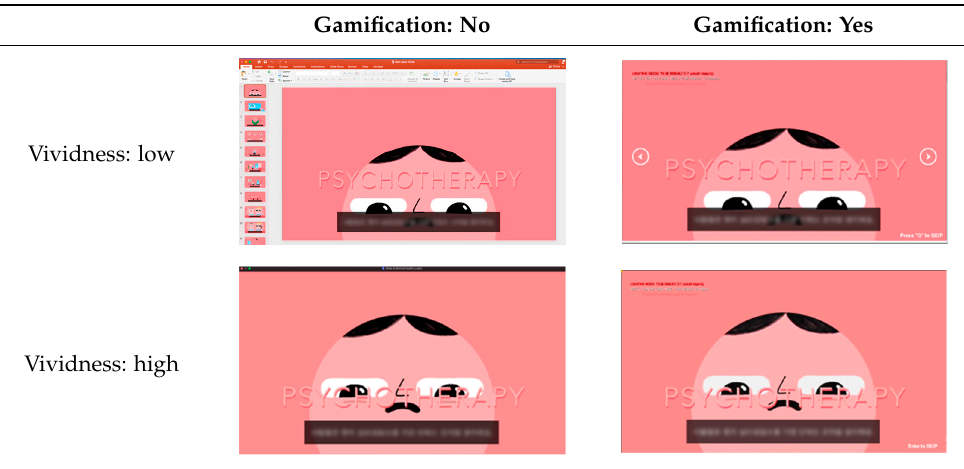
Table 2. Stimuli differing 2 × 2 between-subjects design.